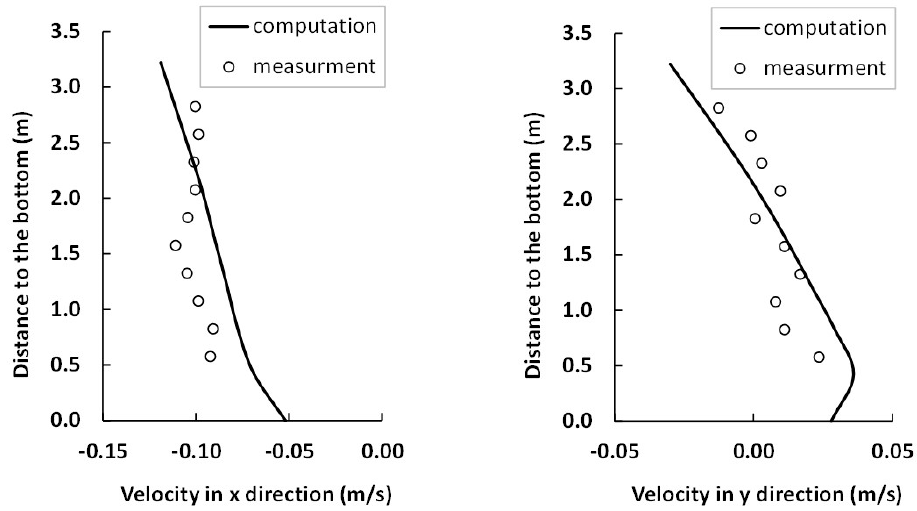
Figure 6. Observed and simulated velocity at Station A (11:25 a.m., 19 November 2003).